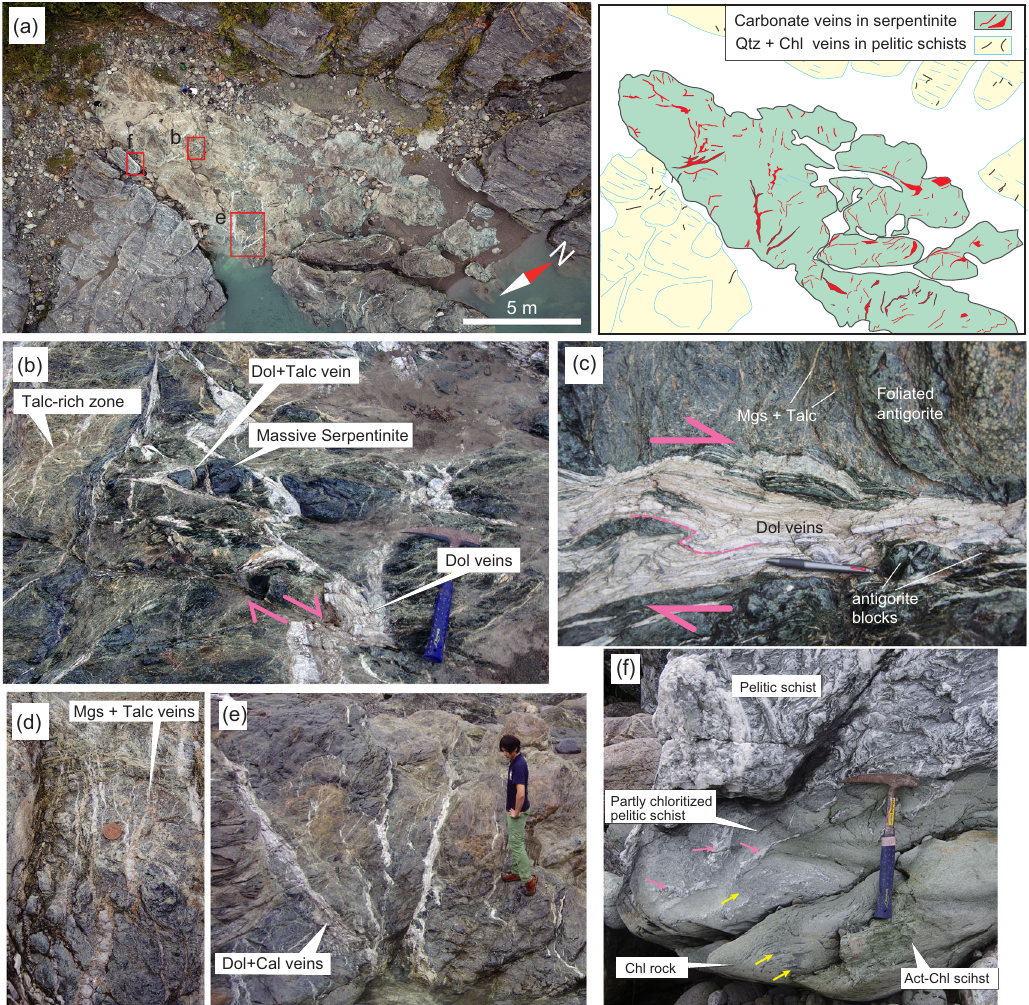
Fig. 1 Field characteristics of the carbonated serpentinite body in Higuchi, Sanbagawa belt, Japan. a Drone photograph and schematic illustration (at right) of the Higuchi serpentinite body with carbonate veins. Open rectangles indicate the locations of b , f , and e , respectively. b Dolomite veins cut through massive serpentinite blocks. c Layered dolomite veins that have experienced shear deformation. d Magnesite + talc veins. e Thick dolomite + calcite veins associated with fragments of serpentinite blocks. f Chlorite rock and actinolite – chlorite schist at the boundary between pelitic schist and the Higuchi serpentinite body. Yellow and pink arrows indicate relict bands of graphite and quartz-rich material, respectively. Mgs magnesite, Dol dolomite, Cal calcite, Chl chlorite, Act